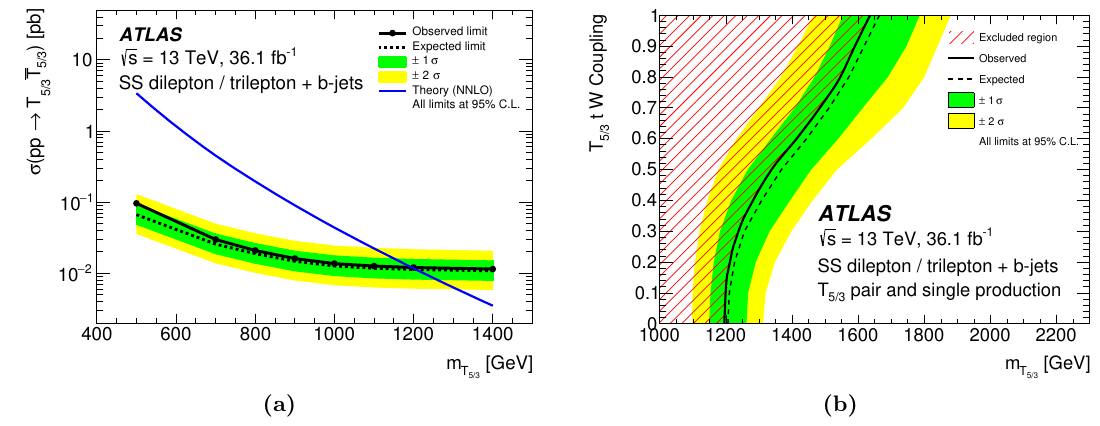
Figure 10 . (a) Expected and observed limits on vector-like T pair production as a function of 5 = 3 mass. The NNLO theory prediction is shown as the continuous line. (b) Expected and observed limits on vector-like T single- plus pair-production as a function of mass and T tW coupling. 5 = 3 5 = 3 In both plots, the expected 95% CL limits are shown with their 1 and 2 standard deviation (cid:6) (cid:6) bands and it is assumed that the branching ratio ( T Wt ) = 5 = 3 ! B